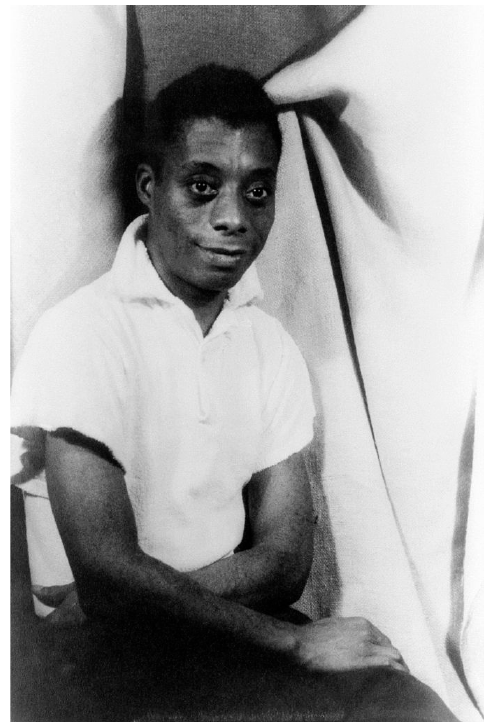
Figure 1. Photo by © CORBIS/Corbis via Getty Images.